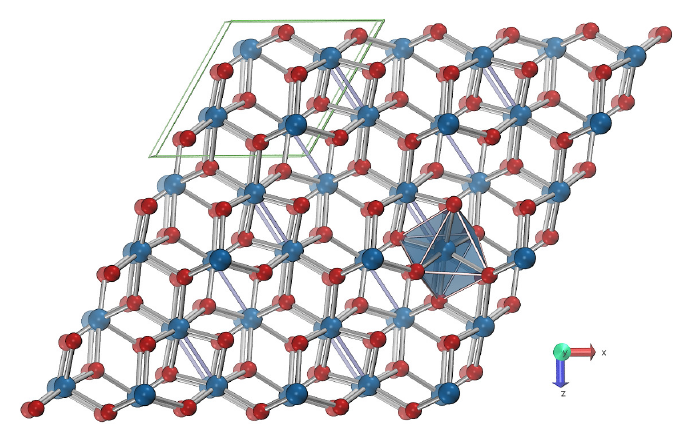
Figure 2. Crystal structure of MoO 2 of monoclinic symmetry (Mo blue, O red), atomic coordinates and cell parameters are taken from Ref. [36]. Short Mo-Mo contacts are represented as blue sticks. The monoclinic unit cell is highlighted in green. The distorted octahedral coordination of Mo by O is represented as transparent polyhedron. A 3 × 2 × 3 supercell was